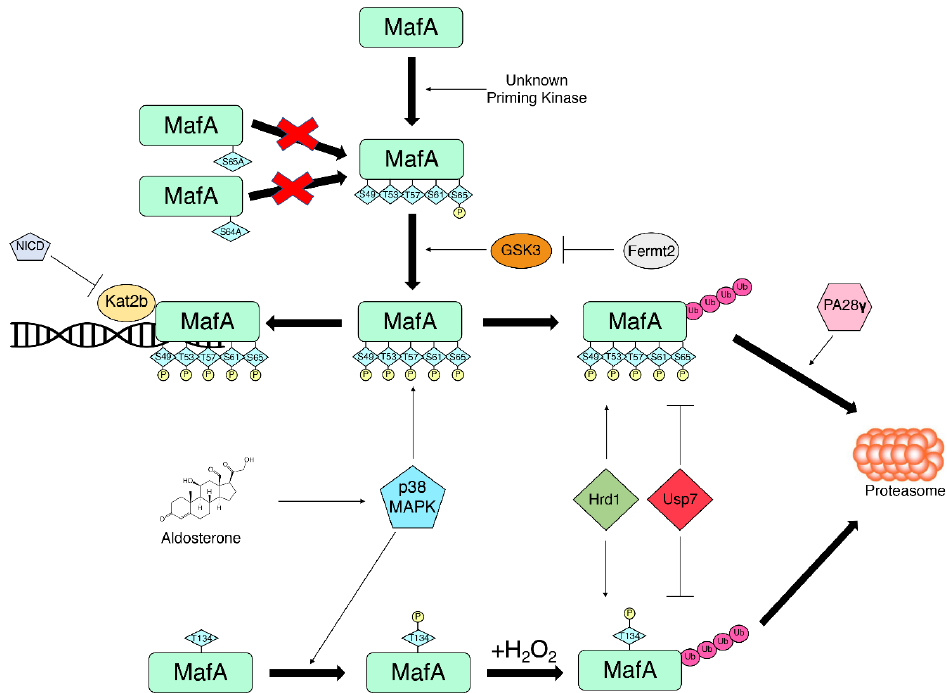
Figure 2. Regulators of MafA phosphorylation and ubiquitination fine-tune the balance between MafA transcriptional activity and MafA degradation.